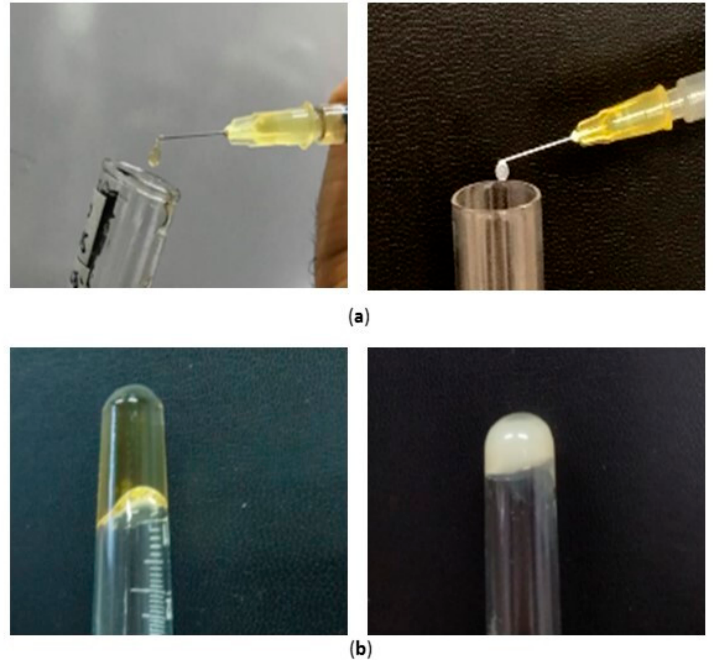
Figure 8. Photographs showing: ( a ) the syringeability of M-TNH (left) and S-TNH (right) at room temperature; ( b ) the gelation at 35 °C of M-TNH (left) and S-TNH (right).